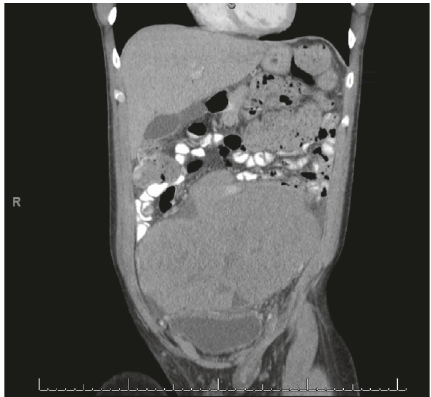
Figure 1: Coronal CT showing mass discreet from undescended left testicle.